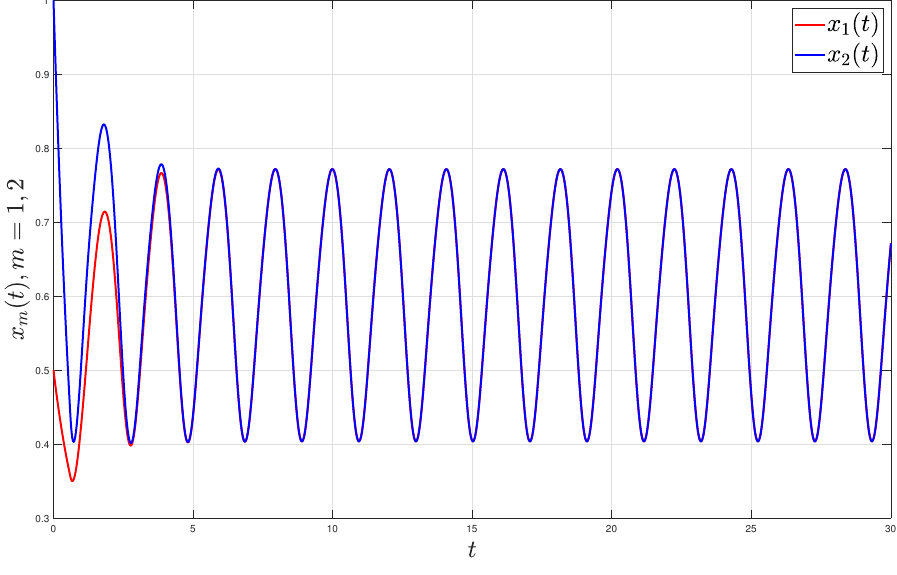
Figure 2. Waveform diagram with 0.6 = τ > τ ∗ = 0.5303, the system with a Hopf